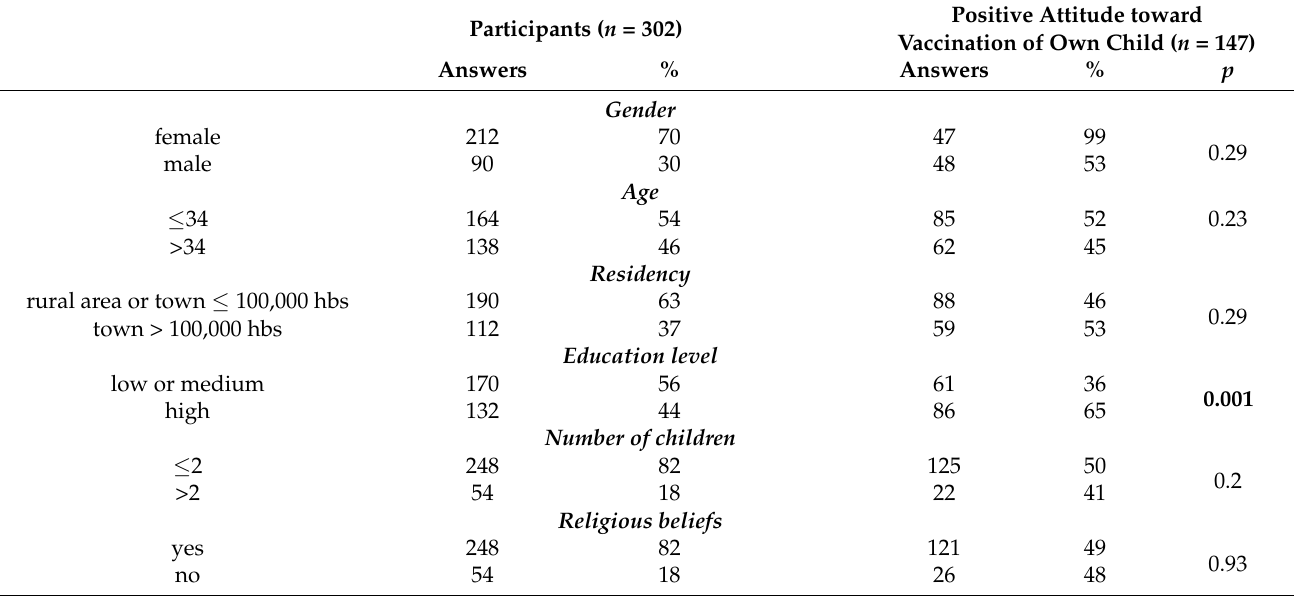
Table 3. Positive attitude towards HPV immunization of own